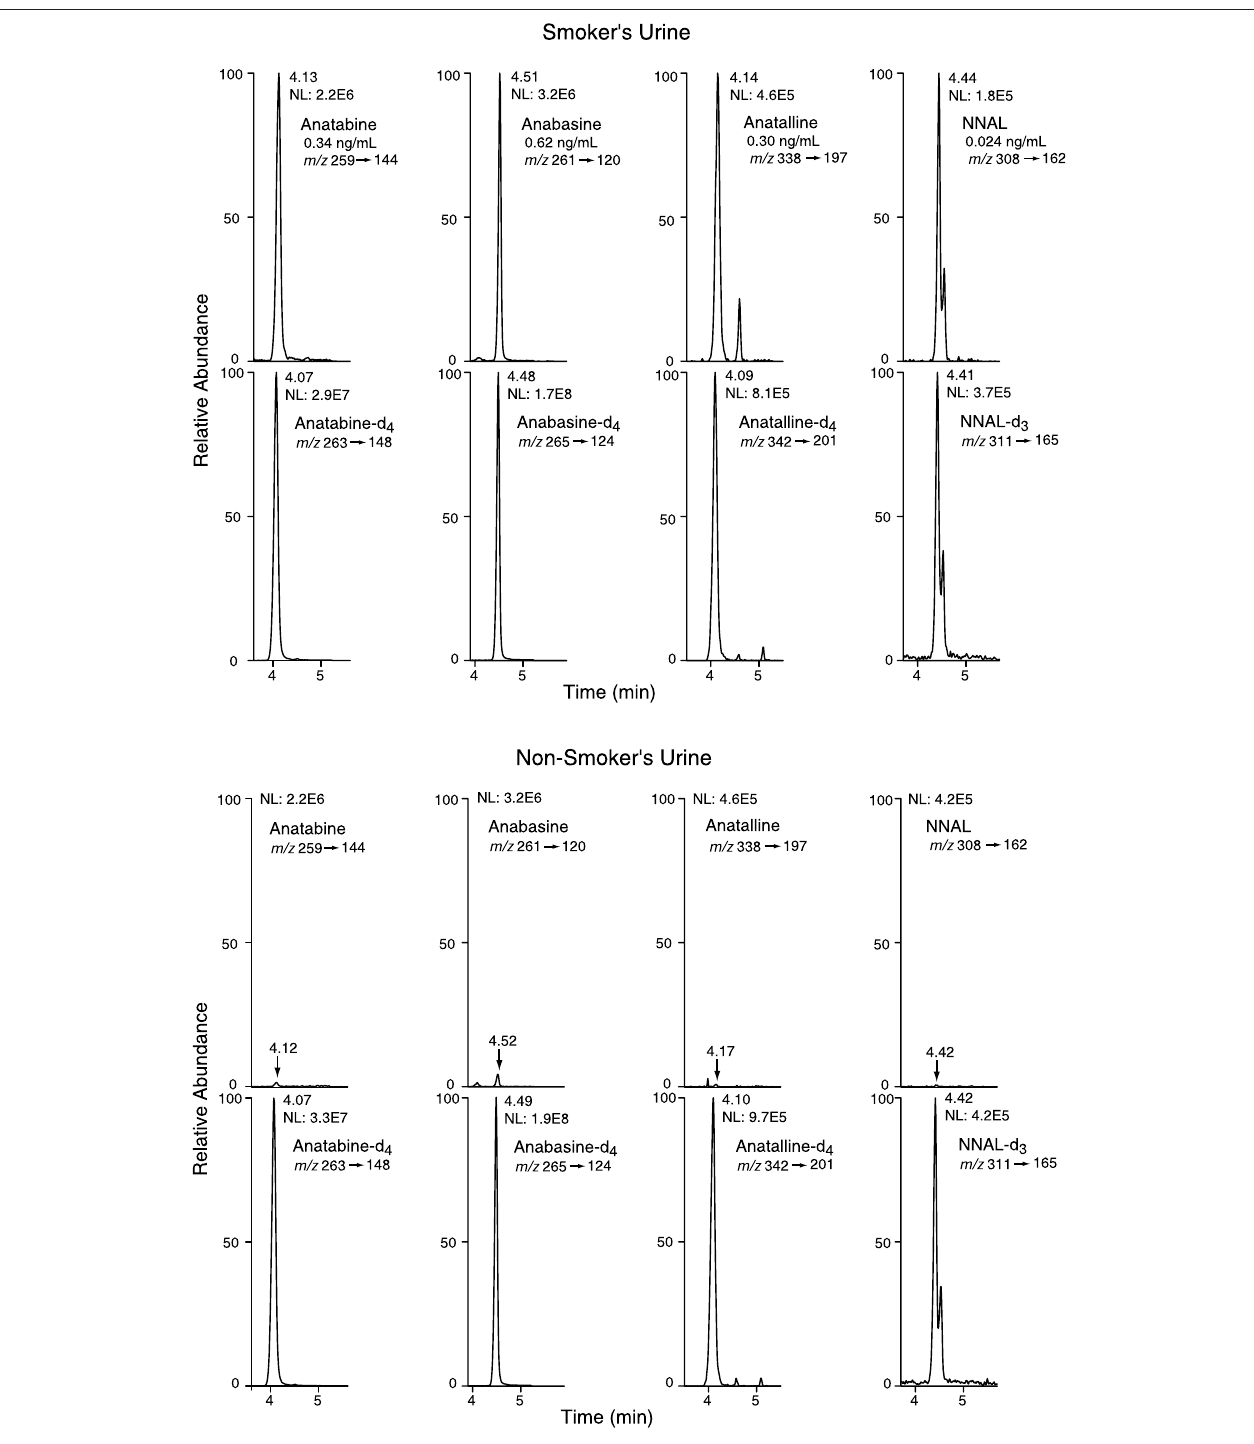
FIGURE6| Selectedreaction monitoring (SRM)chromatogramsfromurine analyzedbyMethod 2.Analytepeaks inthenon-smoker ’ schromatogram werescaled to match those of the smoker ’ s urine chromatogram. The internal standard concentrations were anabasine-d 4 and anatabine d 4 , 20 ng/ml; anatalline-d 4 , 0.8 ng/ml; NNAL-d 3 , 0.6 ng/ml. There are two partially resolved NNAL and NNAL-d 3 peaks, because NNAL exists as two slowly (on the timescale of the chromatography) equilibrating syn and anti isomers with respect to the N-N bond.